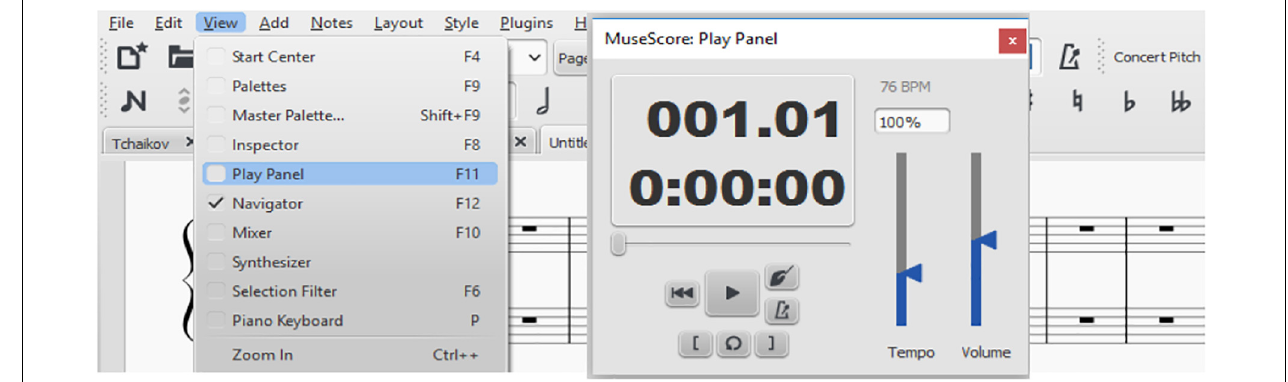
FIGURE 6 | MuseScore View Menu (left) and Play Panel (right) .